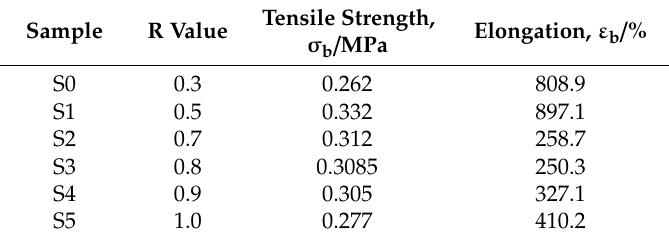
Figure 3. Mechanical properties: e ff ect of R value for polytriazole elastomers S0–S5. Table 1. Mechanical properties of polytriazole